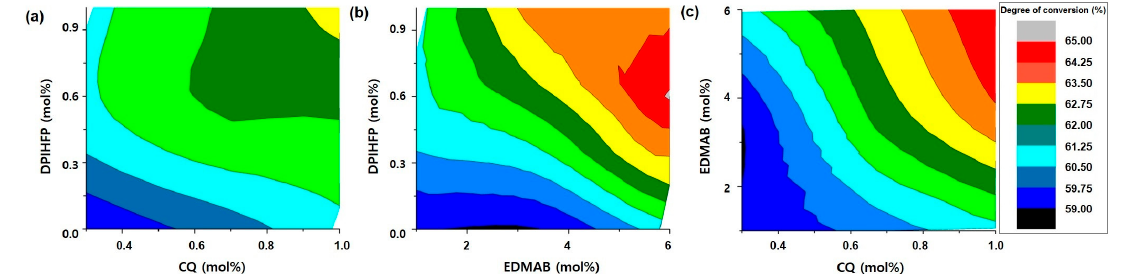
Figure 5. Contour plots for 27 kinds of resin combinations with different molar ratios of CQ, EDMAB, and DPIHFP. The area with the same degree of conversion was painted the same color when EDMAB was set to 1 mol % ( a ), CQ to 0.3 mol % ( b ), and DPIHFP to 0 mol % ( c ). ( a ) had a relatively wider contour plot, whereas ( b ) and ( c ) exhibited more narrow areas.